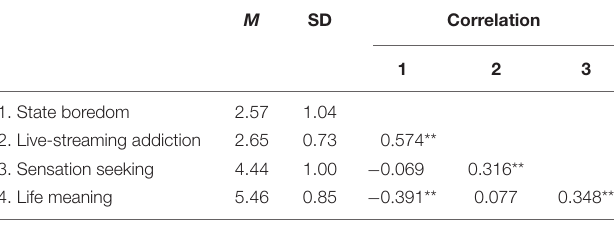
TABLE 7 | Means, SDs, and correlations of variables in Study